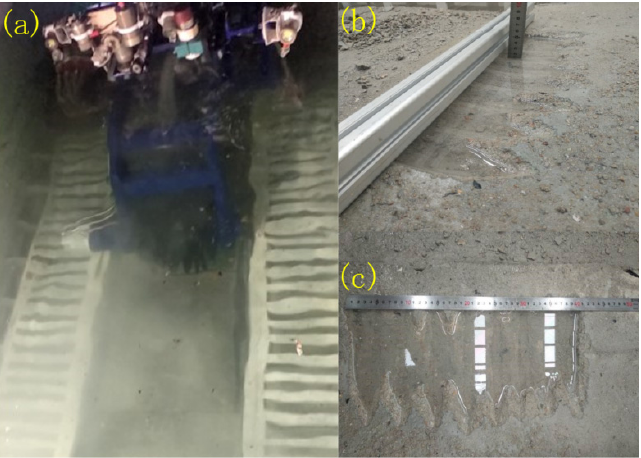
Figure 14. ( a )Tank testing, ( b ) depth of the grooves, ( c ) grooves on the cement block.